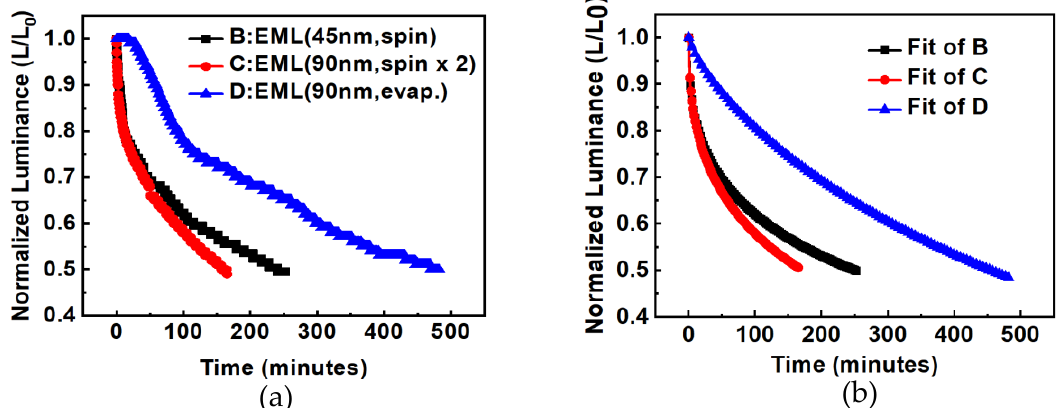
Figure 4. Lifetime measurement of OLEDs with different EML deposition methods and thicknesses,